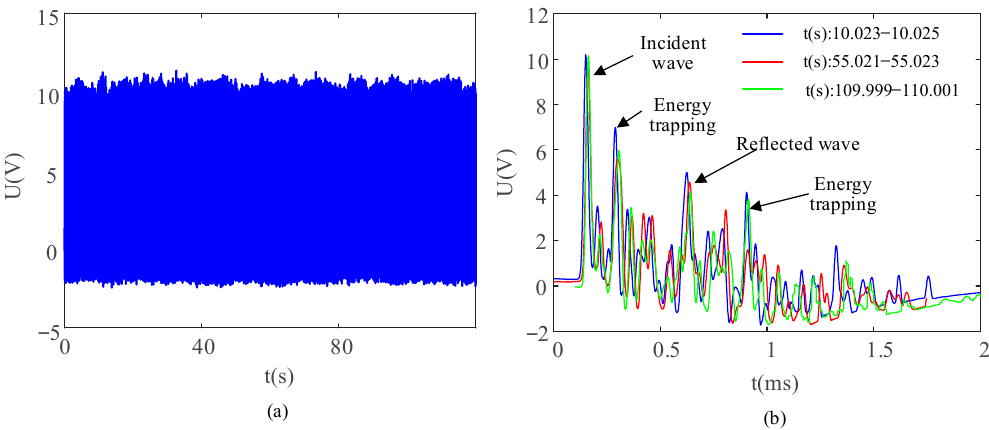
Figure 5. ( a ) Recorded voltage signals of the PEH in the impact process of 120 s and ( b ) typical waveforms of different time periods.